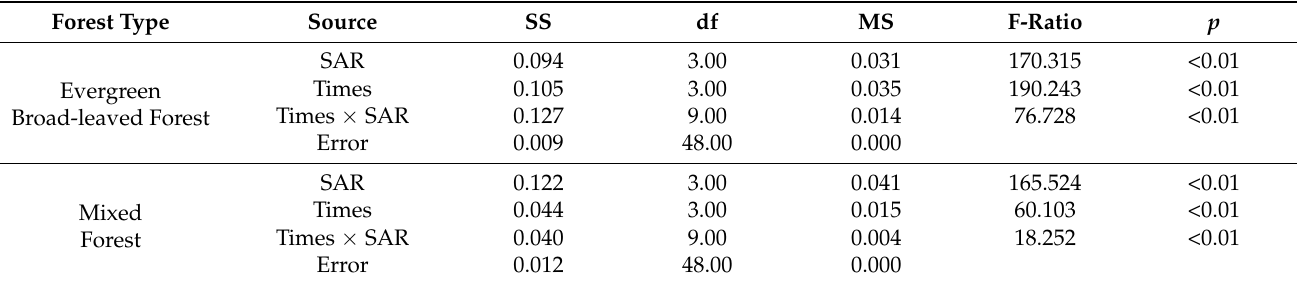
Table 8. ANOVA of soil acid phosphatase